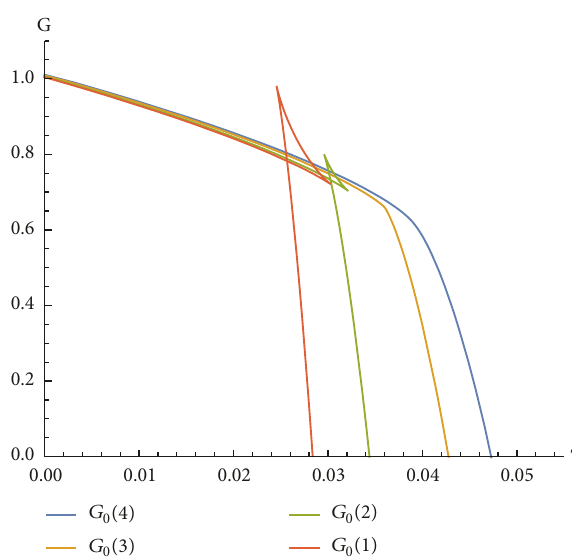
Figure 5: Gibbs free energy of charged AdS black holes in rainbow gravity. The blue line 𝐺 0 (3) corresponds to the critical pressure 𝑃 푐 ≈ 0.0024 , the line 𝐺 (4) corresponds to pressure 𝑃 > 𝑃 0 푐 , and the others corresponds to pressure 𝑃 < 𝑃 푐 . We have set 𝑄 = 1 , 𝜂 = 1 , 𝑚 = 0 .